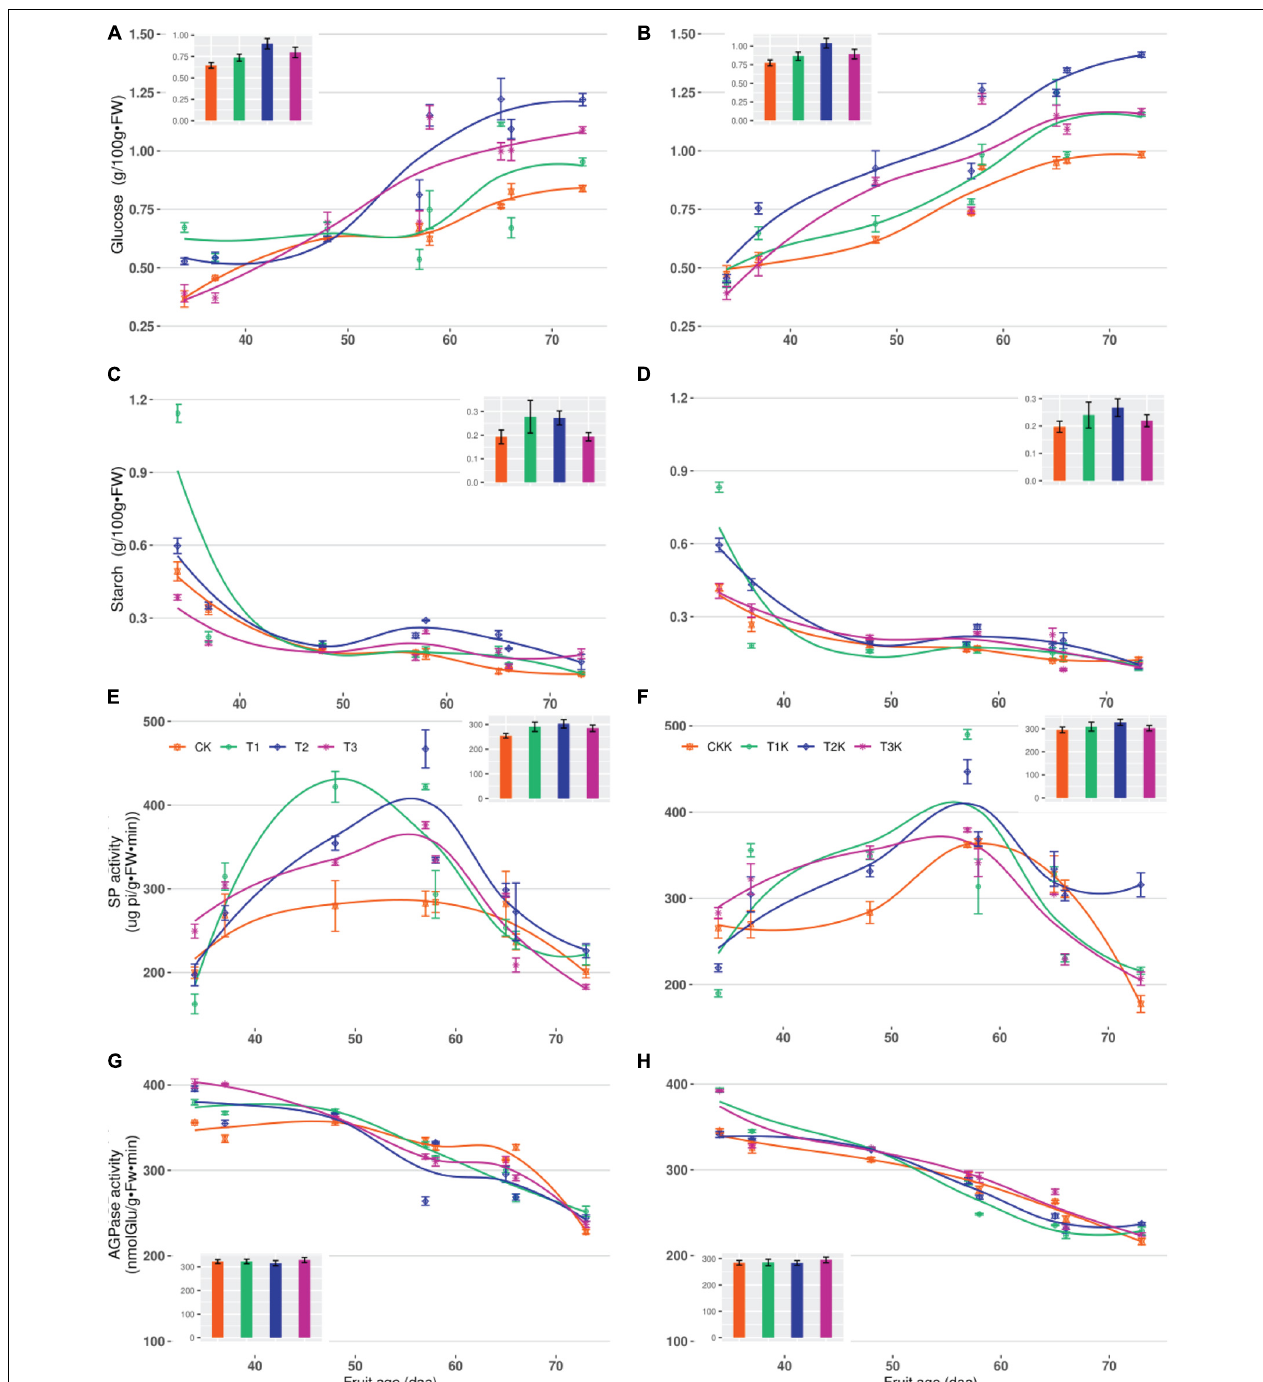
FIGURE 5 | Related sugars and starch metabolic enzymes activity in fruit during the growth stages. Measured glucose (points), starch (points), starch phosphorylase (points), starch synthase (points) and their corresponding fitted curves (lines) for different water and potassium treatments are shown as functions of DAA. The bar chart showed the average value of each treatment. (A) Variation of Glucose with fruit age for different water treatments. (B) Variation of Glucose with fruit age for different water and potassium treatments. (C) Variation of Starch with fruit age for different water treatments. (D) Variation of Starch with fruit age for different water and potassium treatments. (E) Variation of SP activity with fruit age for different water treatments. (F) Variation of SP activity with fruit age for different water and potassium treatments. (G) Variation of AGPase activity with fruit age for different water treatments. (H) Variation of AGPase activity with fruit age for different water and potassium